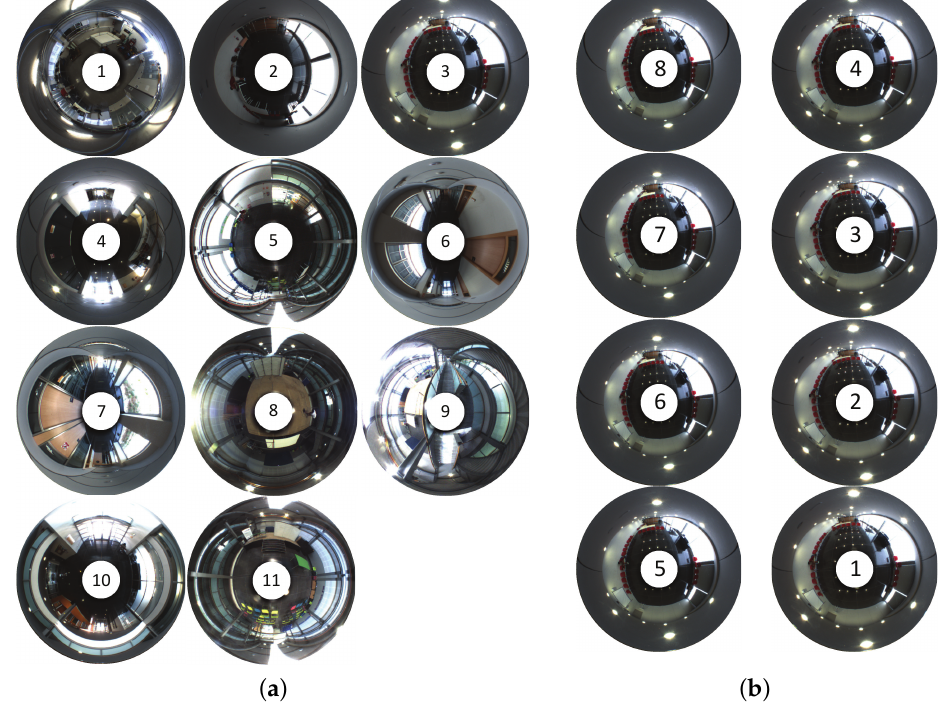
Figure 10. ( a ) One sample omnidirectional image per indoor environment is shown. ( b ) Images captured in Indoor Environment 3 from the maximum altitude (eight) to the minimum altitude (one).